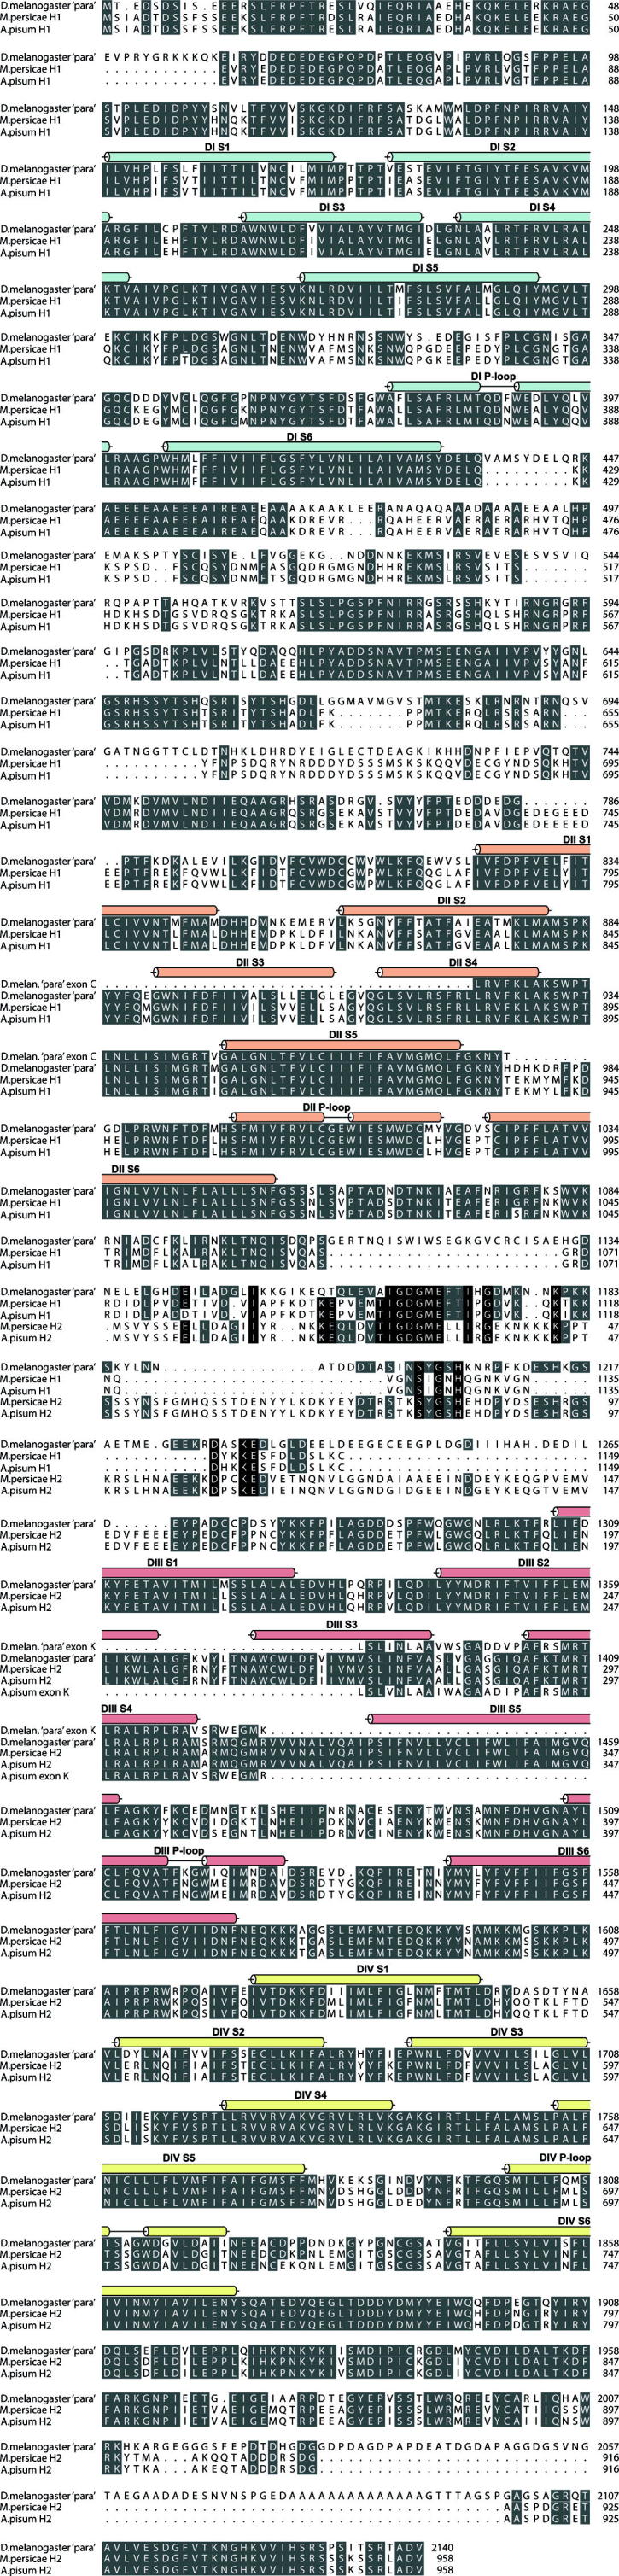
Alignment of fruitfly (D. melanogaster) DmNav1 (para) voltage-gated sodium channel and the pea aphid (A. pisum) and peach potato aphid (M. persicae) channel H1 and H2 subunits. The M. persicae cDNAs are highly conserved at the amino acid level with the A. pisum H1 and H2 sequences (98.7% (DI–DII); 97.7% (DIII–DIV)). Transmembrane helices from different domains are indicated by bars in different colours above the sequences. Identical amino acids are highlighted in grey. [Note the apparent evolutionary sequence duplication (highlighted in black) in the DII-DIII intracellular loop to generate the novel 5′ end for H2].